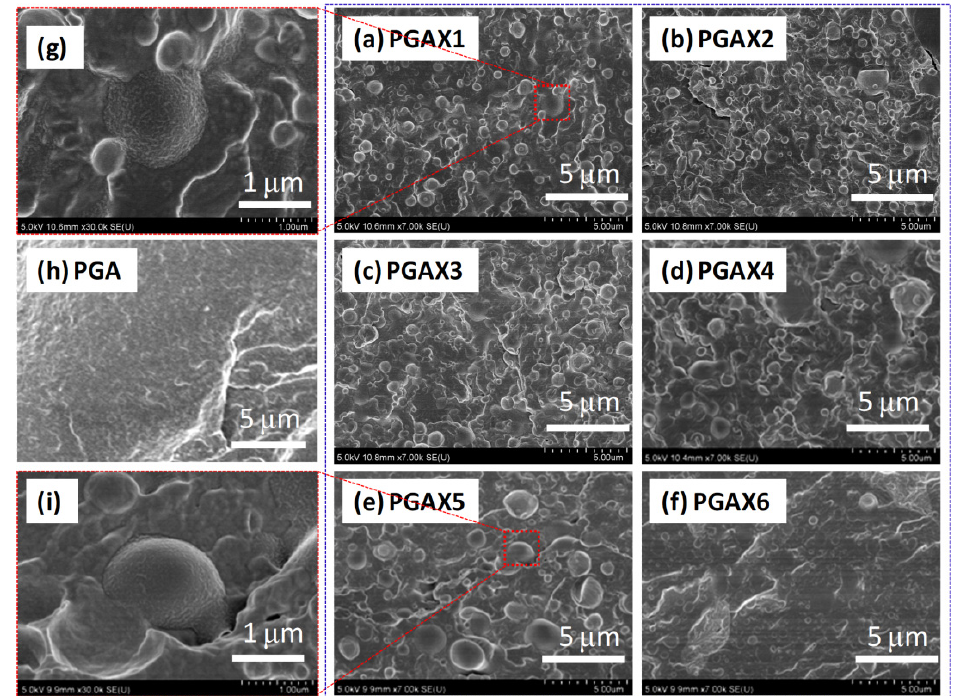
Figure 1. SEM images of the compounded PGAX blends ( a – f ) with magnification in ( g , i ) and the pristine PGA ( h ).